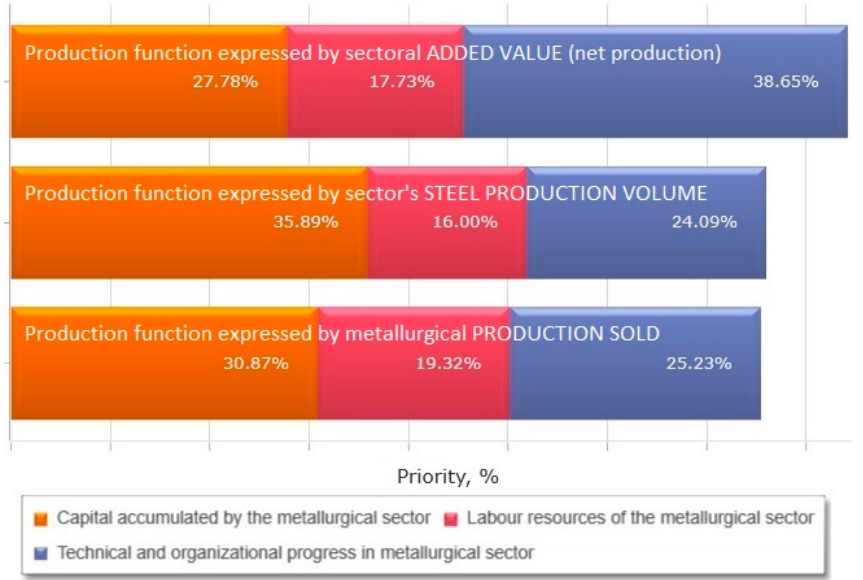
Figure 3. Criteria-sensitive results of experts’ rankings in frames of AHP decision alternatives. Source: own elaboration based on research results.